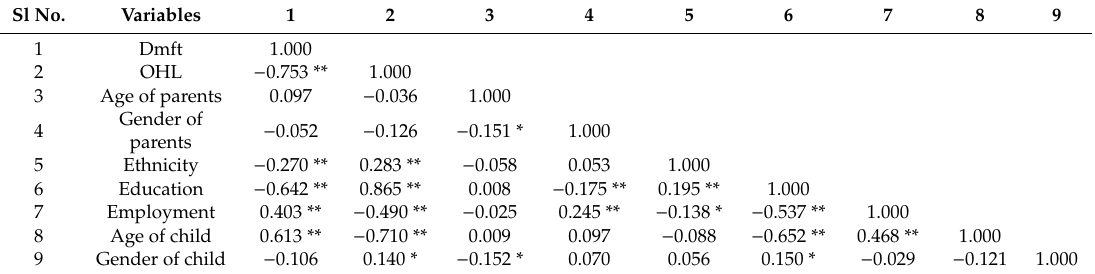
Table 4. Association of OHL and sociodemographic